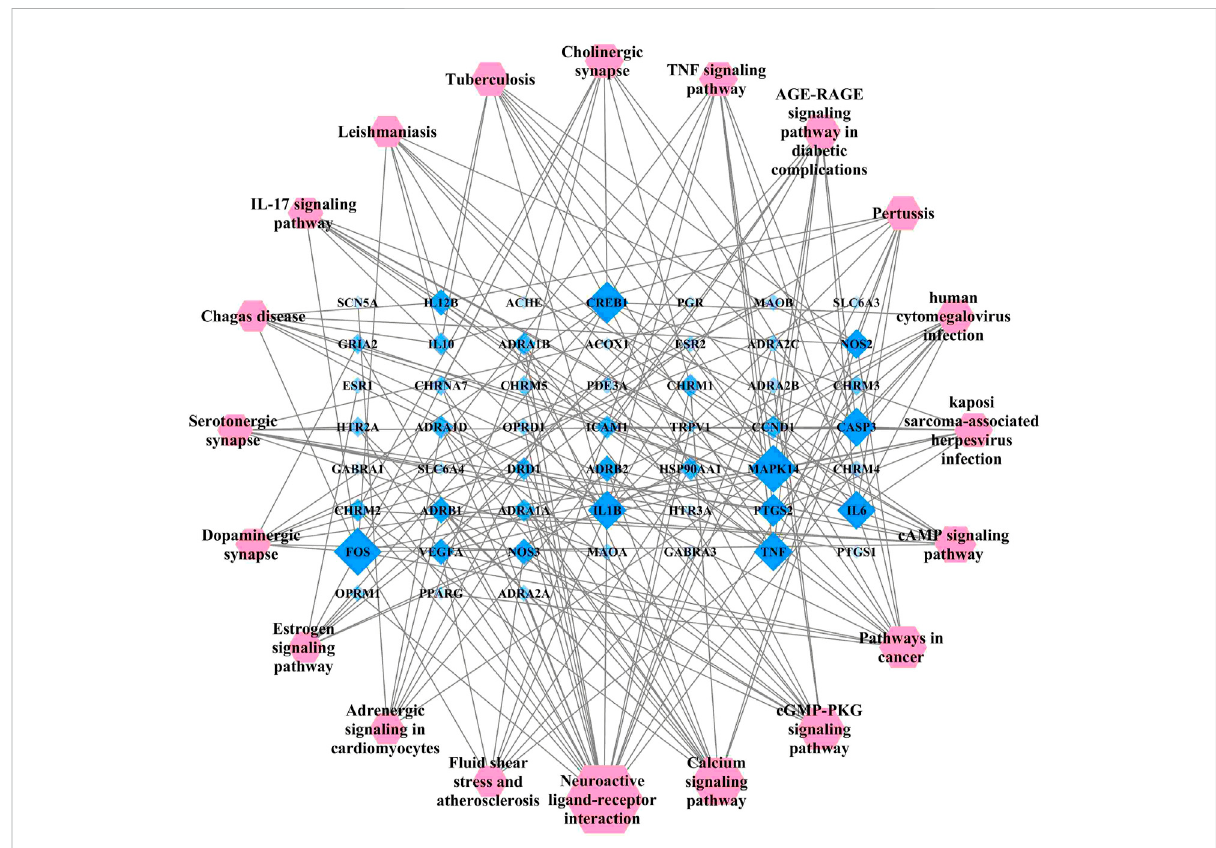
FIGURE 7 Network diagram of the KEGG pathway, the target of Ligusticum chuanxiong-Piper longum couplet medicines for the treatment of